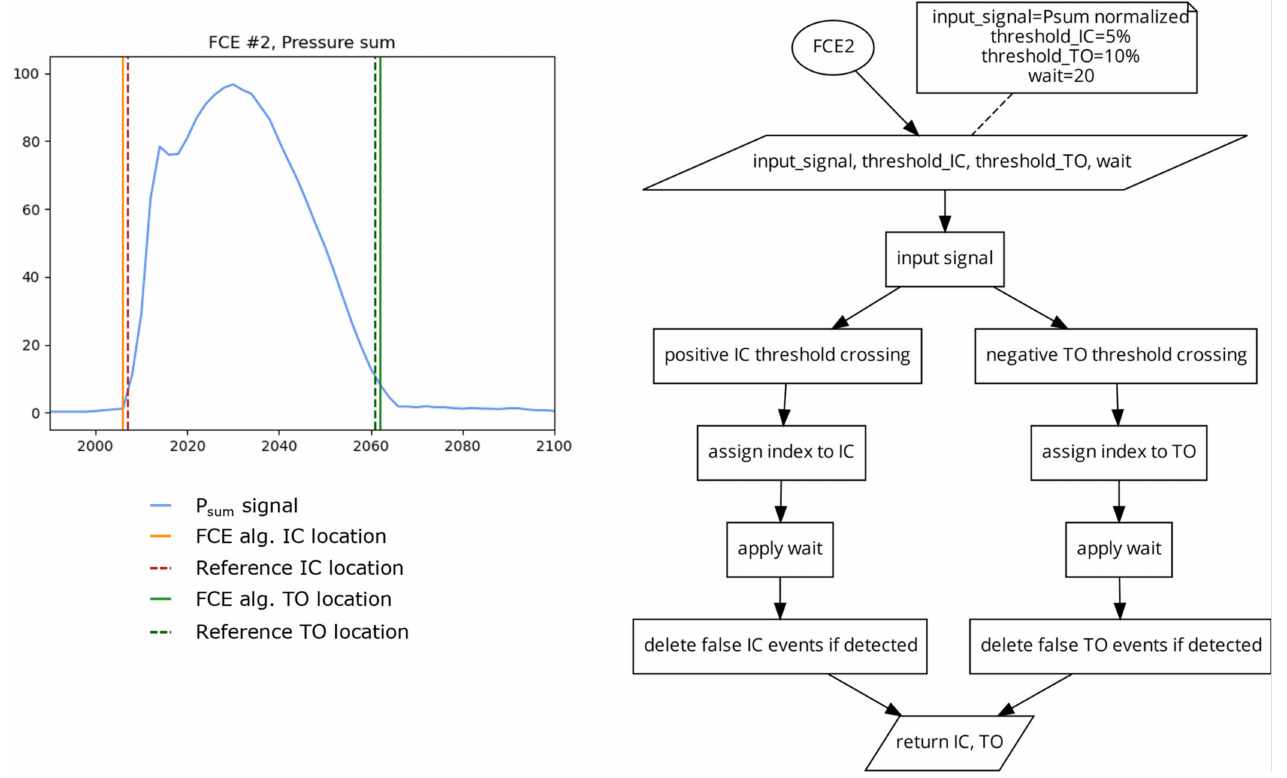
Figure 5. Plot ( left ) displaying a single stride and the location of the reference FCEs (dashed vertical) and the FCEs (solid vertical) determined by the FCE2 algorithm ( right ) using a 5% of the maximum signal threshold for IC and a 10% of the maximum signal threshold for